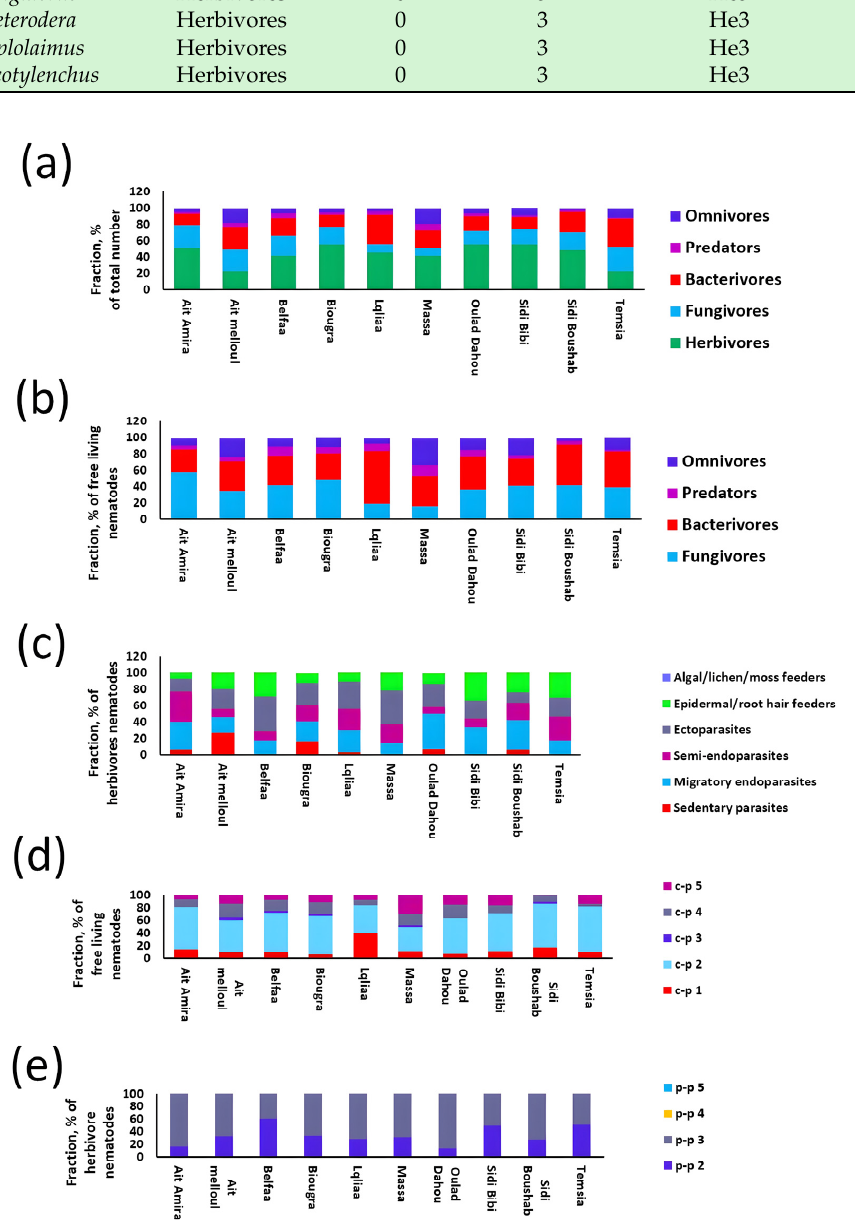
Figure 2. Fraction of soil nematode communities that occurred in wheat fields of Southern Morocco. ( a ) Fraction percentage of the total nematode numbers according to their respective feeding group. ( b ) Fraction of free-living nematodes. ( c ) Fraction of herbivorous (plant-parasitic) nematodes. ( d ) Fraction of free-living nematodes according to c-p (colonizer-persister) values. ( e ) Fraction of PPNs according to p-p (plant-parasitic) values. Table 2. Main nematode taxa identified from wheat-growing areas in southern Morocco.